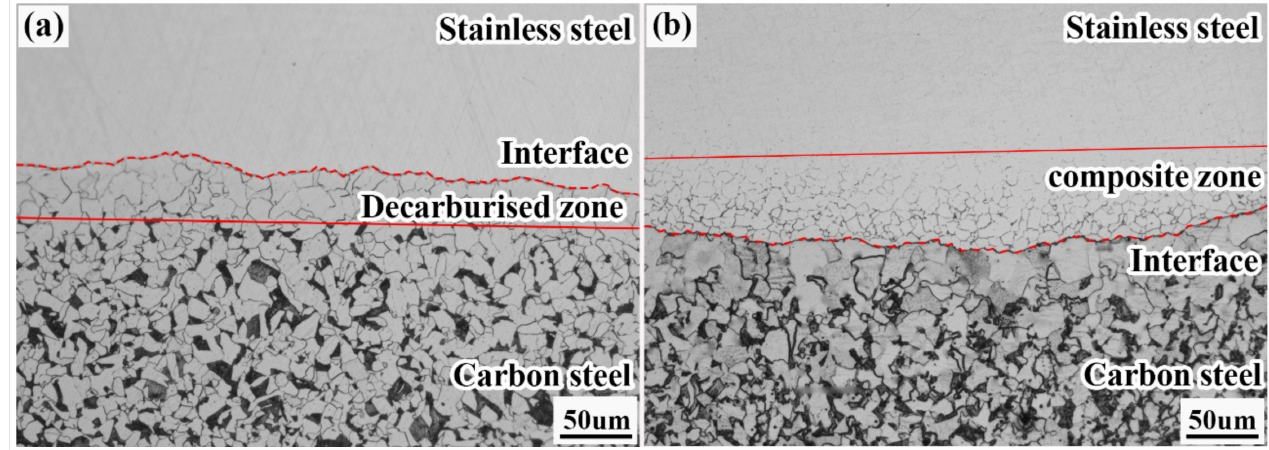
Figure 9. Metallographic organisation of the composite interface of the clad rebar: ( a ) carbon steel side; ( b ) stainless steel